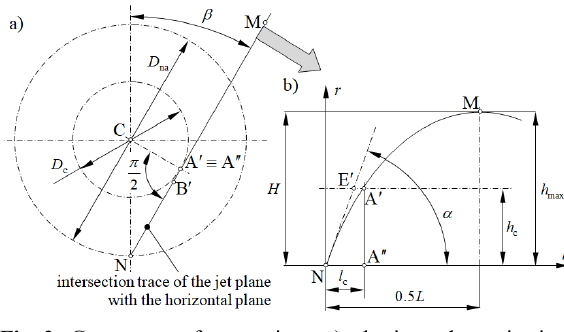
Fig. 3. Geometry of one jet: a) horizontal projection, b) projection on jet plane